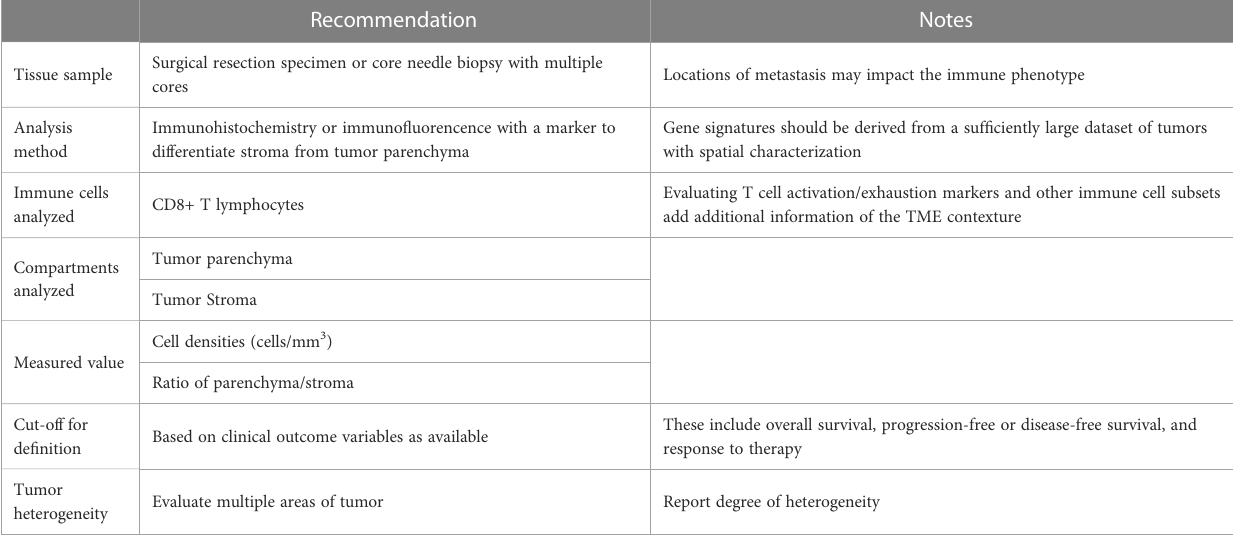
TABLE 1 Recommendation for evaluation and reporting Immune Exclusion in cancer